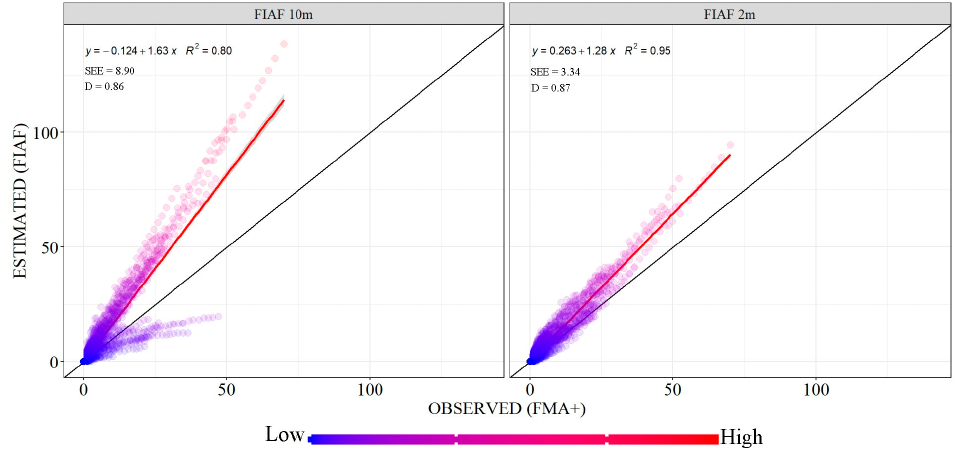
Figure 4. Regression analysis between the observed FMA+ model and the estimated FIAF for the 2 and 10 m levels in Itatiaia National Park, Brazil.